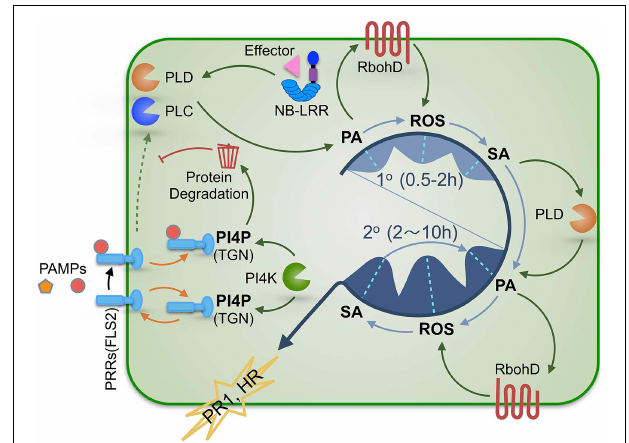
FIGURE 1 | A schematic illustration of the regulatory roles of PA and PI4P in SA-dependent plant defense signaling. Plants activate immune responses upon recognition of PAMPs or effectors by PRRs or NB-LRR immune receptors, respectively. Bioactive PA and PI4P play distinct roles in regulating defense signaling. PA production via immunity-activated PLC and/or PLD is required for SA-dependent defense activation and exhibits a biphasic pattern (1 ◦ & 2 ◦ ) that precedes the kinetically similar biphasic ROS generation and SA accumulation. Therefore, we propose that these three signaling molecules are sequentially interconnected with PA most likely being the initial signal of the PA-ROS-SA signaling module. The first wave (1 ◦ ) of PA-ROS-SA signal amplification (occurring during PTI and ETI) may potentiate the second wave (2 ◦ ) of PA-ROS-SA signal amplification (occurring mostly during ETI or strengthened PTI), constituting a tunable signaling module for defense in plant cells. PI4P derived from PI4KIII β 1 and PI4KIII β 2 functions to maintain the homeostasis of PRRs via facilitating its recycling and/or degradation, thereby preventing inappropriate activation of PTI in the absence of pathogens and allowing measured PTI signaling upon pathogen attack. PAMPs, pathogen-associated molecular patterns; PTI, PAMP-triggered immunity; ETI, effector-triggered immunity; PRR, pattern recognition receptor; NB-LRR, nucleotide binding site leucine-rich-repeats; PA, phosphatidic acid; PI4P, phosphatidylinositol 4-phosphate; TGN, trans-Golgi network; PLC, phospholipase C; PLD, phospholipase